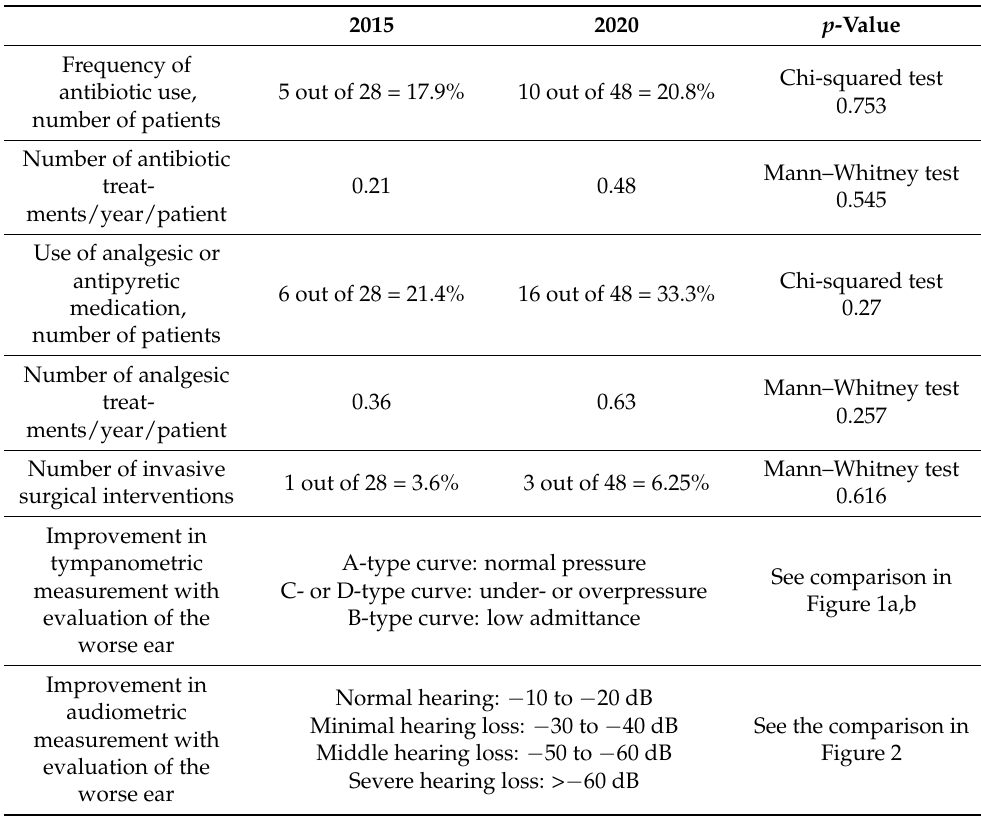
Table 4. Results of primary outcome